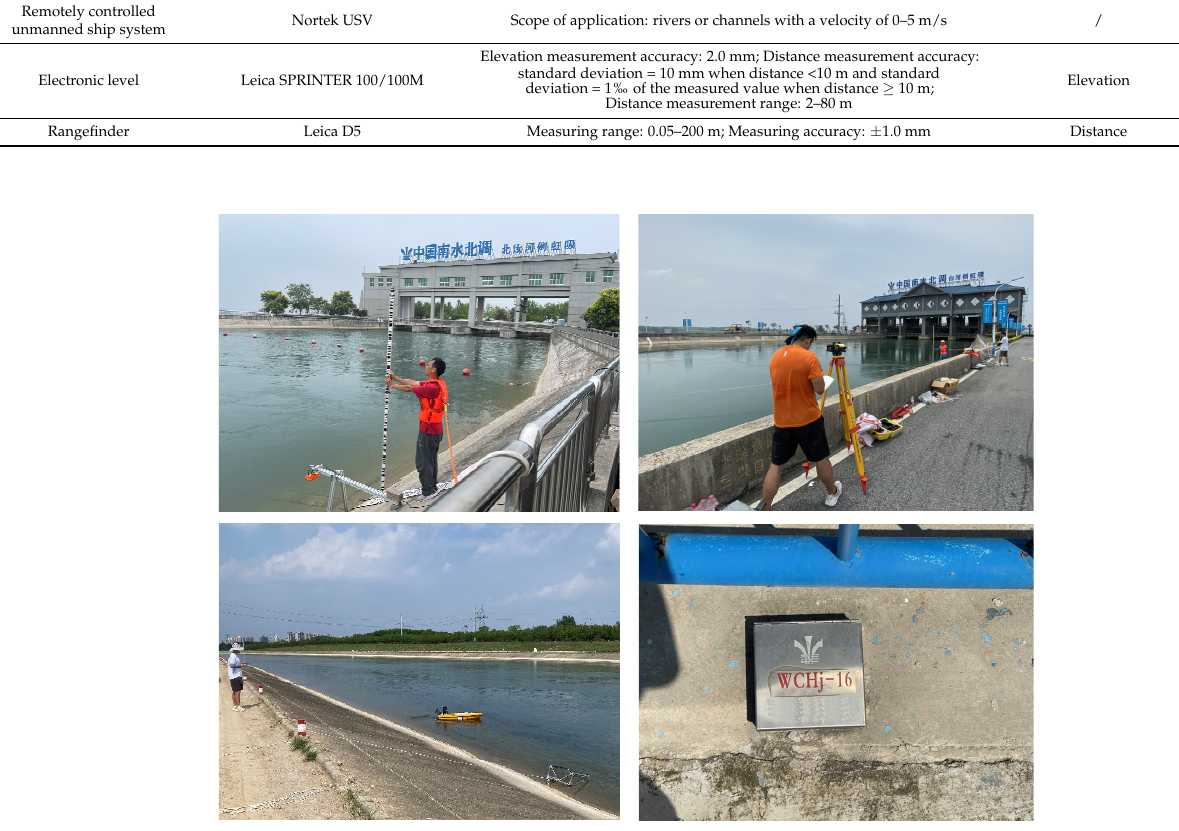
Figure 3. Observation instruments and benchmark of prototype observation.